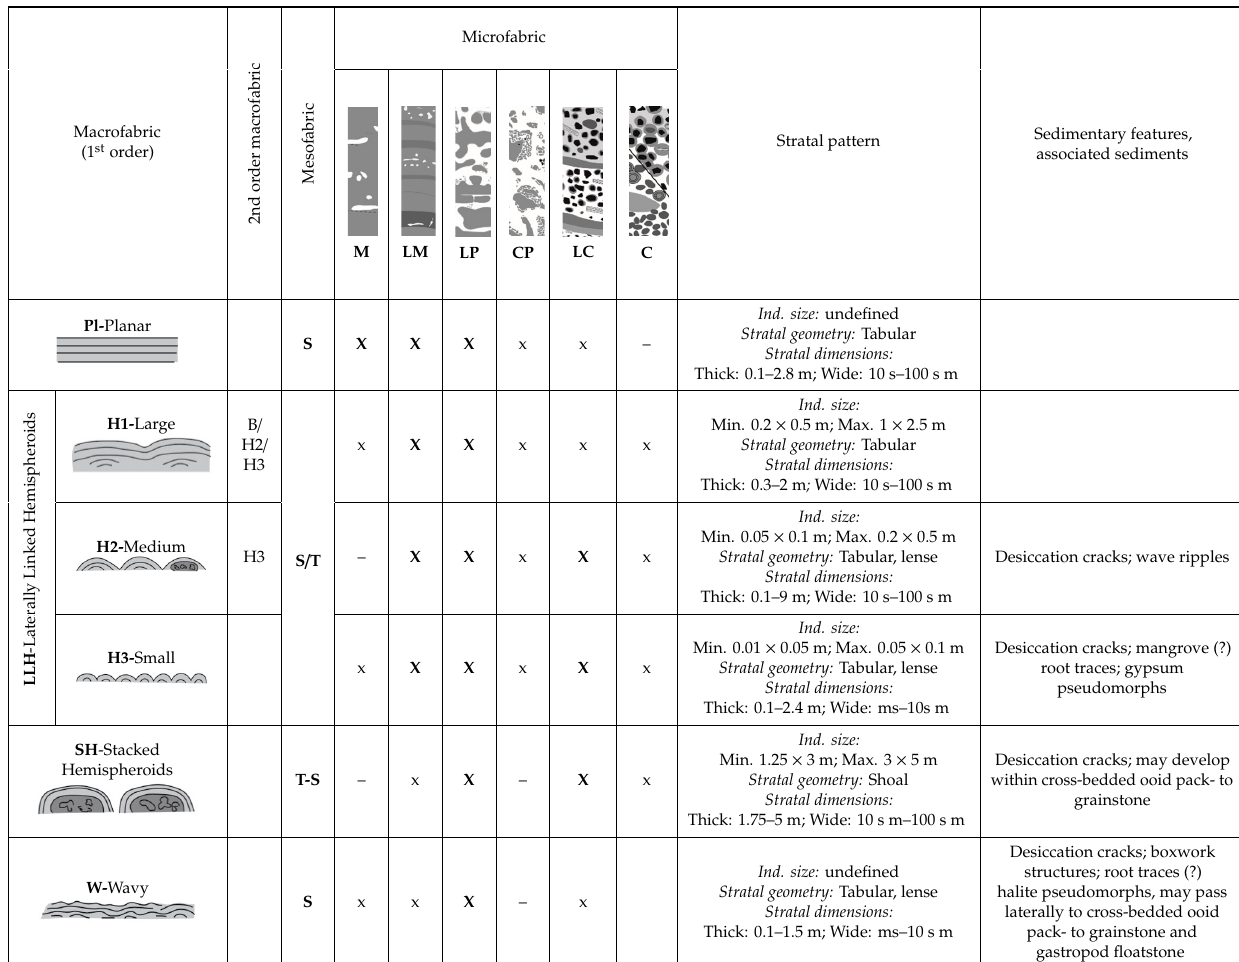
Ind. size: undefined Stratal geometry: Tabular, lense Stratal dimensions: Thick: 0.1–1.5 m; Wide: ms–10 s m Stratal dimensions: Thick: 0.1–1.5 m; Wide: ms–10 s m